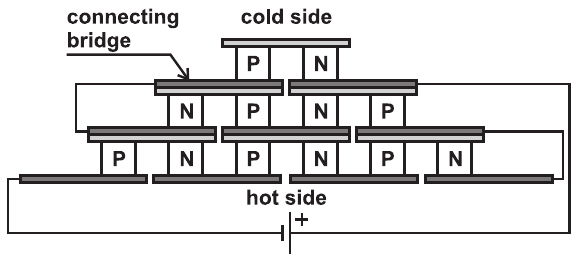
Figure 1. Serial interconnections of the